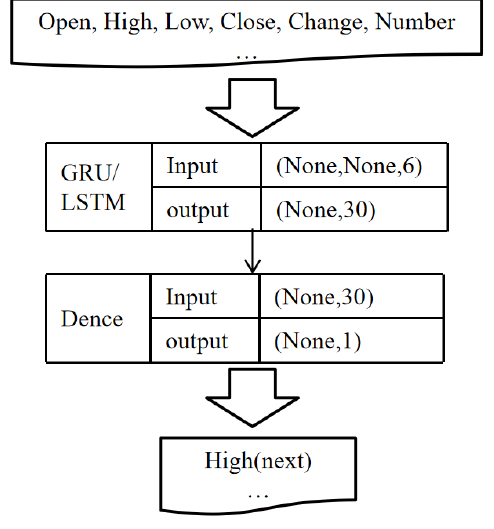
Fig. 7 The flow of a GRU or LSTM in